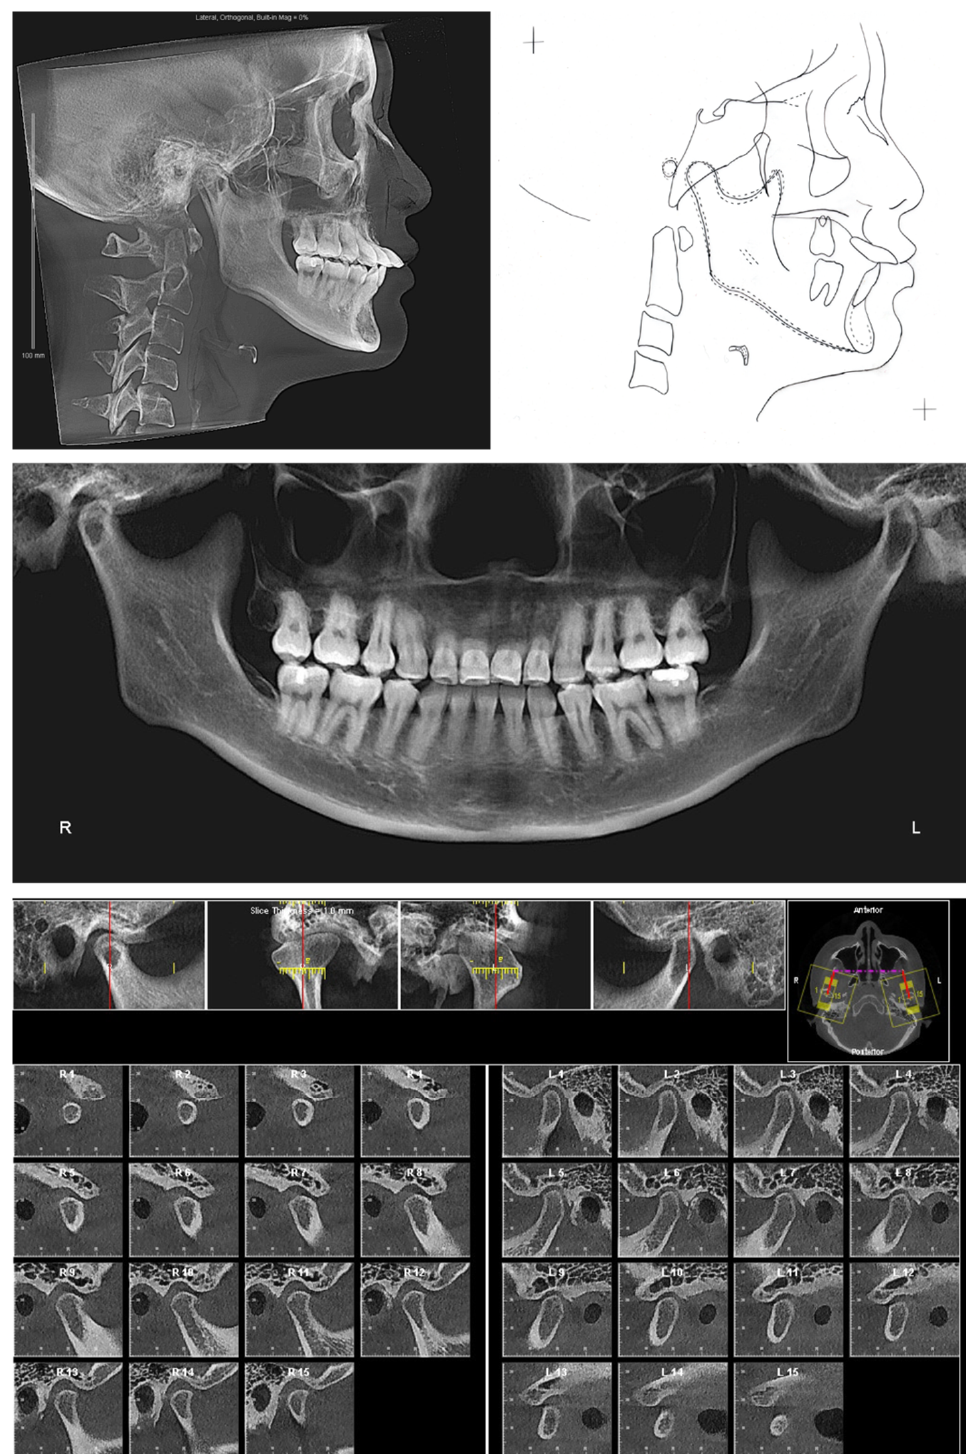
Figure 2. Pretreatment radiographs and cephalometric tracing.